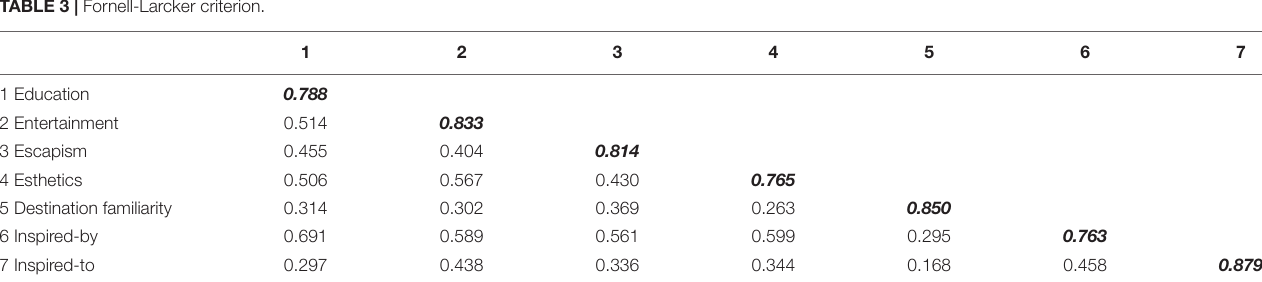
TABLE 3 | Fornell-Larcker